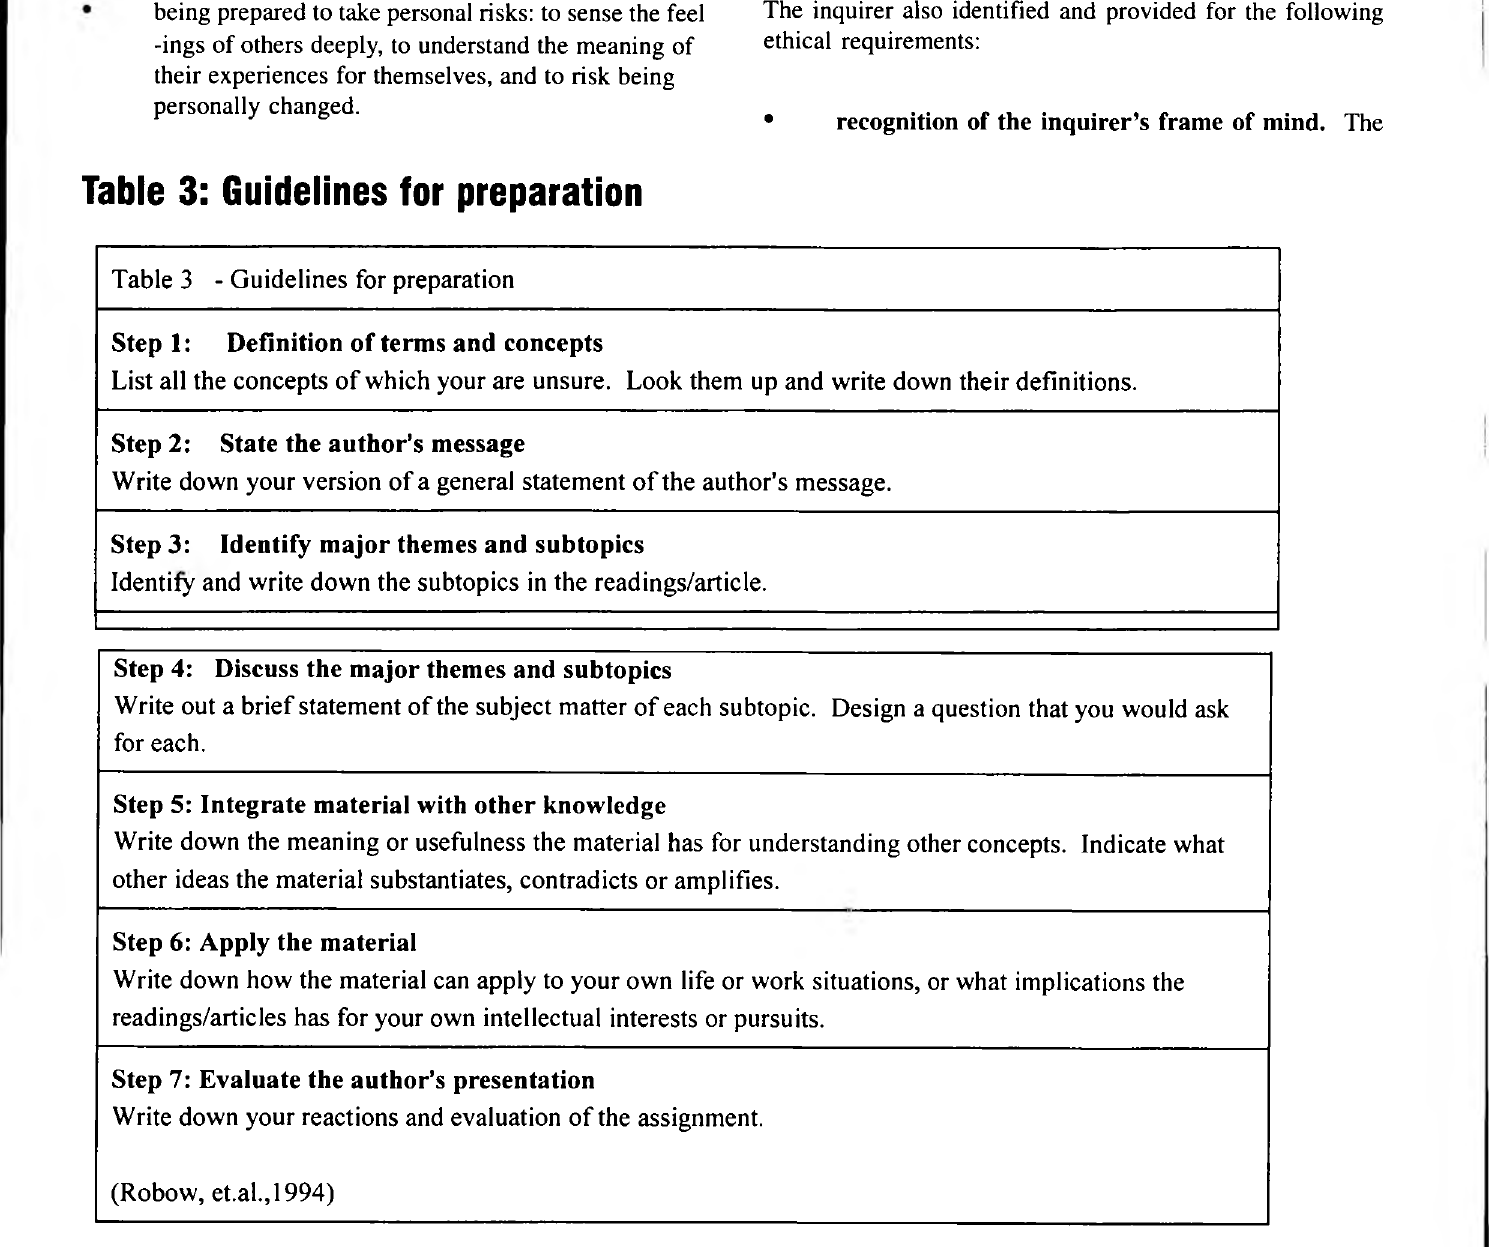
Table 3: Guidelines for preparation Table 3 - Guidelines for